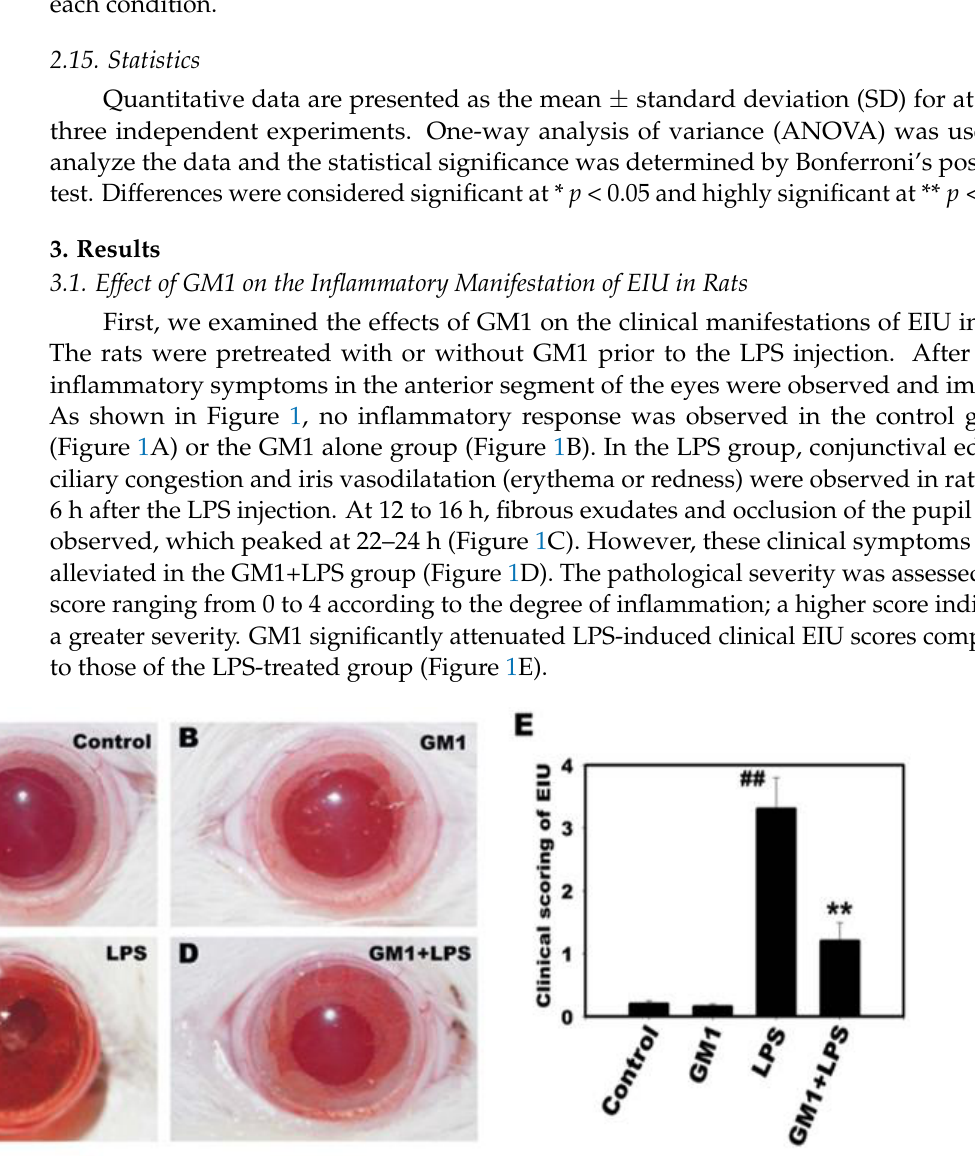
Figure 1. Effect of GM1 on the inflammatory manifestation of EIU in rats. Lewis rats were pretreated with GM1 and then treated with or without LPS for another 24 h. Representative ocular images of the anterior segment for four different treatment groups: control ( A ), GM1 alone ( B ), LPS ( C ), and GM1+LPS ( D ). ( E ) The inflammatory response was significantly reduced in the GM1 pretreatment group compared to the LPS group in terms of clinical scores. Data are presented as the mean ± SD. ## p < 0.01 compared with the control group; ** p < 0.01 compared with the LPS treatment group. Each group contained n = 6